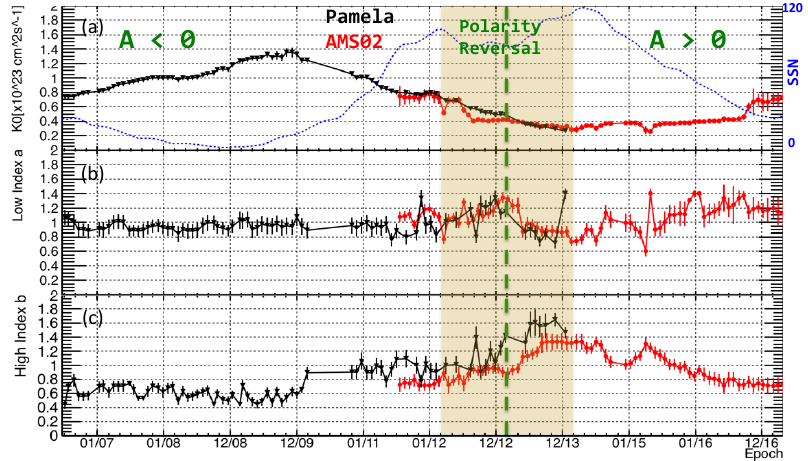
Figure 2. Results for (a) K 0 , (b) spectral index a and (c) spectral index b for all the data sets as a function of time. Dotted line in (a) displays the averaged